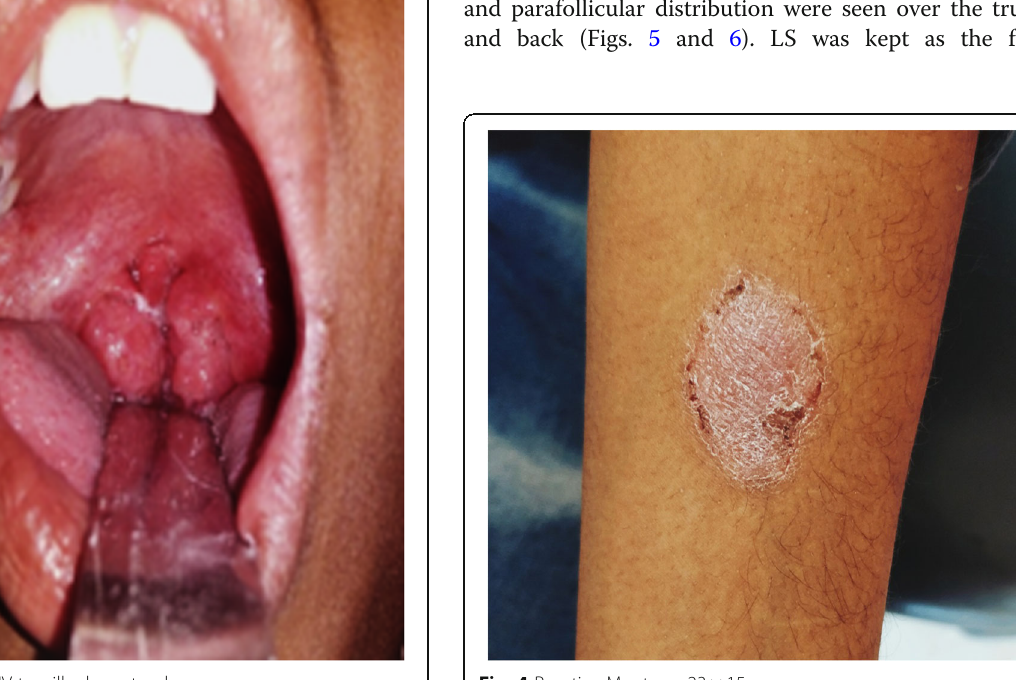
Fig. 2 B/L grade IV tonsillar